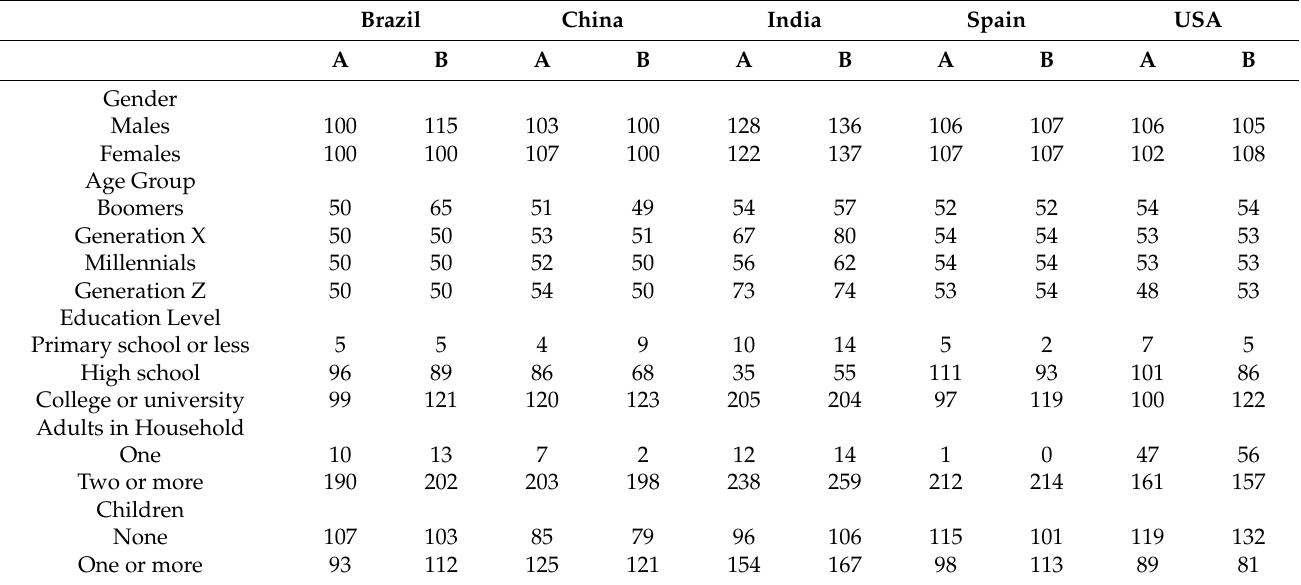
Table 1. Overview of demographic segmentation of respondents who completed the RATA and RATING question formats of the EMS in all five countries 1